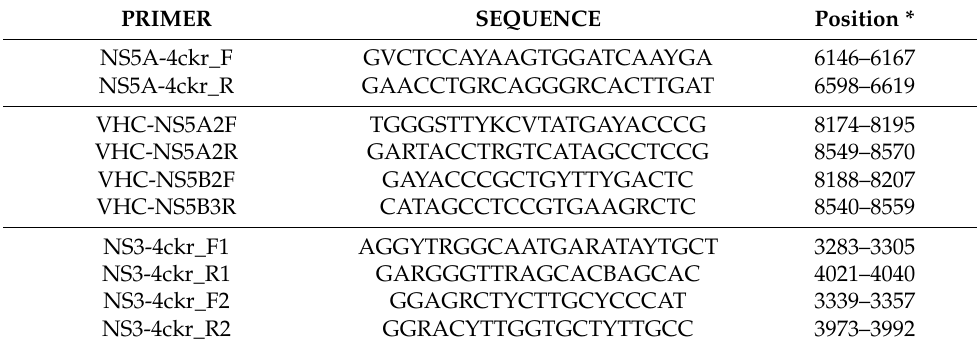
Table 1. Primer pairs for HCV GT4 NS5A, NS5B, and NS3